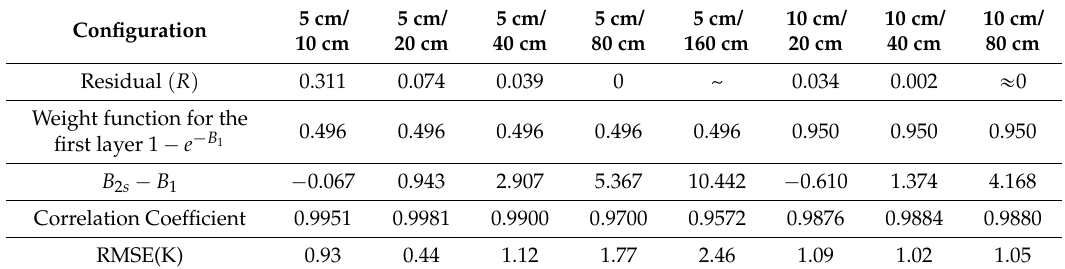
Table 3. Correlation coefficient and RMSE with available six-layer soil moisture/soil temperature